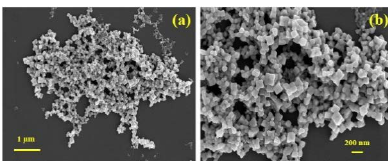
Figure 3. Ag nanoparticles synthesised using Eucalyptus macrocarpa leaf extract. ( a ) Overview of agglomerated Ag nanoparticles and ( b ) enlarged view of Ag nanocubes [92].